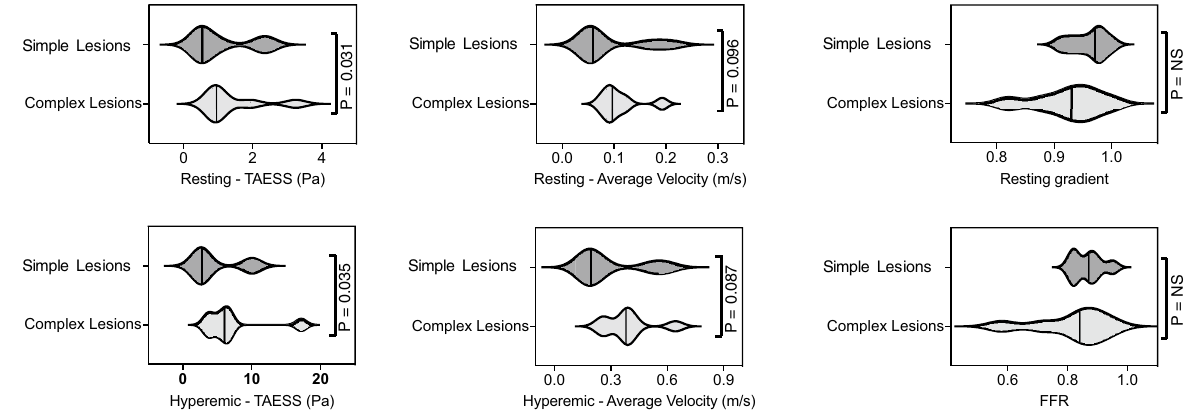
Figure 6. Violin plots to compare time-averaged endothelial shear stress (TAESS), velocity, resting gradient and fractional flow reserve (FFR) in complex versus non-complex lesions at resting and hyperemic physiological states. ESS was averaged over the period of cardiac cycle and is reported as TAESS. Velocity for each patient case was averaged along the length of the stenosis. Solid lack lines identifies the median